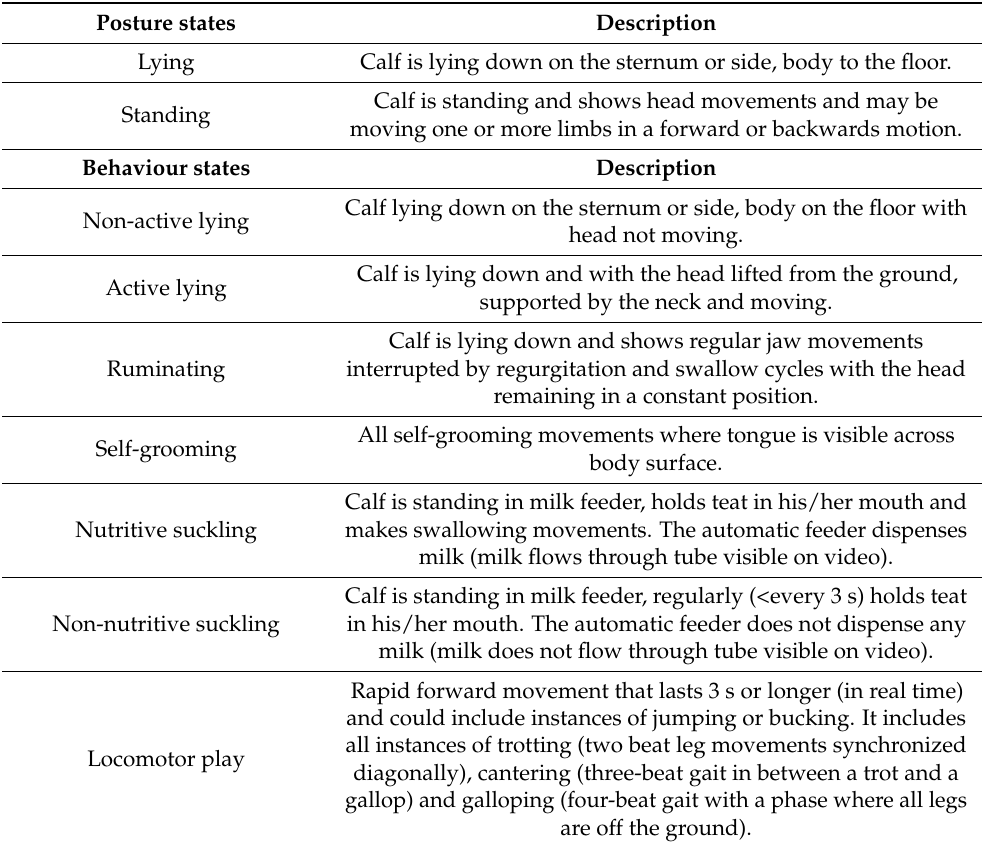
Table 1. Definition of the calf postures and behaviours used for the